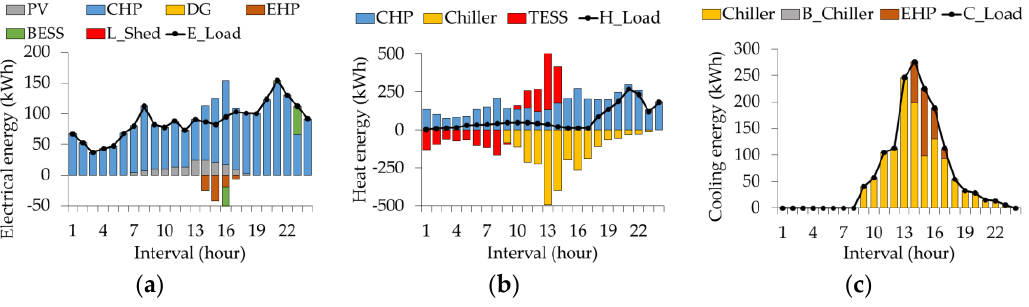
Figure 3. Energy balancing: ( a ) Electrical Energy; ( b ) Heat Energy; ( c ) Cooling Energy.